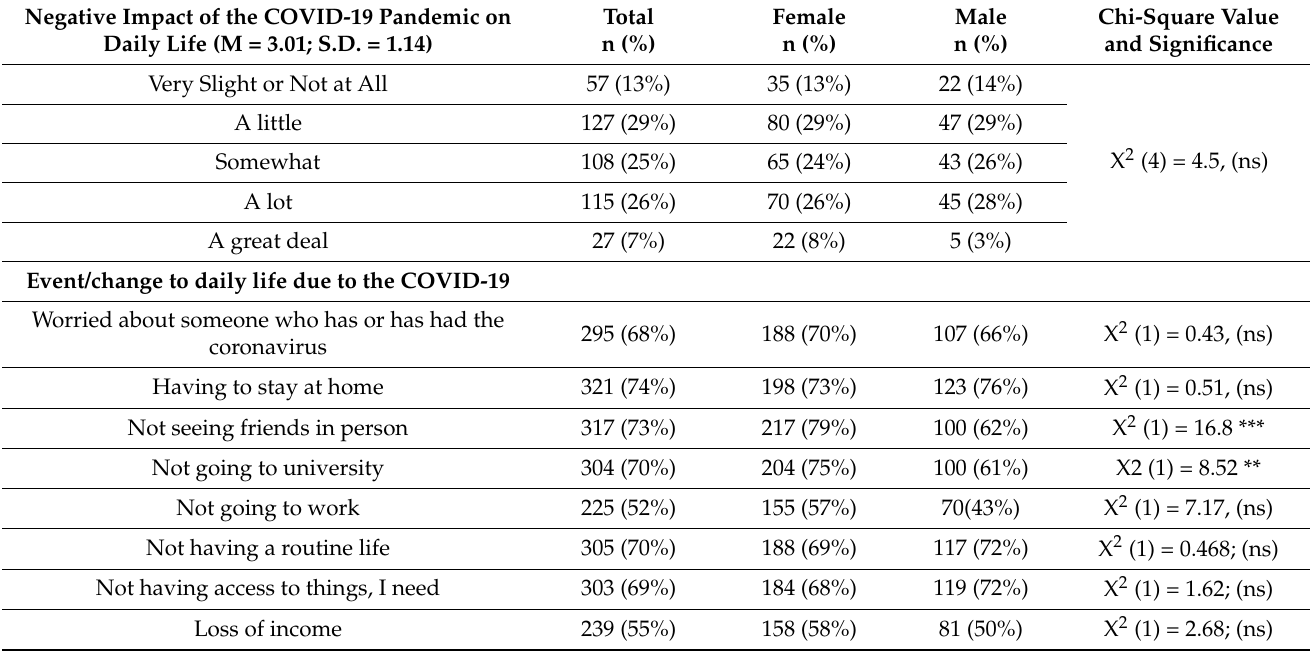
Table 4. Negative Impact of the COVID-19 pandemic on the daily lives of university students (n = 434). Negative Impact of the COVID-19 Pandemic on Daily Life (M = 3.01; S.D. = 1.14)